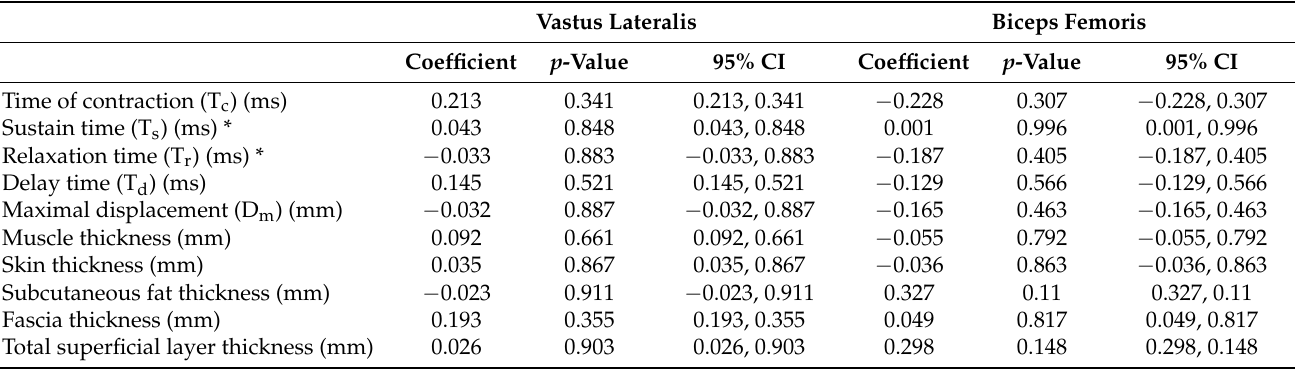
Figure 2. A sample of the elastography and ultrasound thickness measurements for the vastus lateralis ( a , c ) and biceps femoris ( b , d ). The thickness measurements show the calibers placement for skin, subcutaneous fat, and fascia. The SWE images show the hue color distribution of the stiffness and the Young’s modulus kPa results. Table 2. Correlation coefficients for the association between elastography and the other study variables including tensiomyography variables and superficial layers’